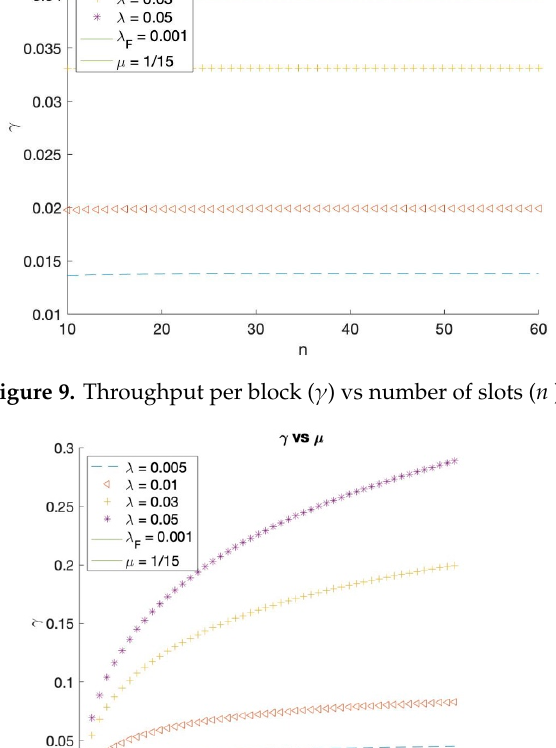
Figure 10. Throughput per block ( γ ) vs rate of slots ( µ